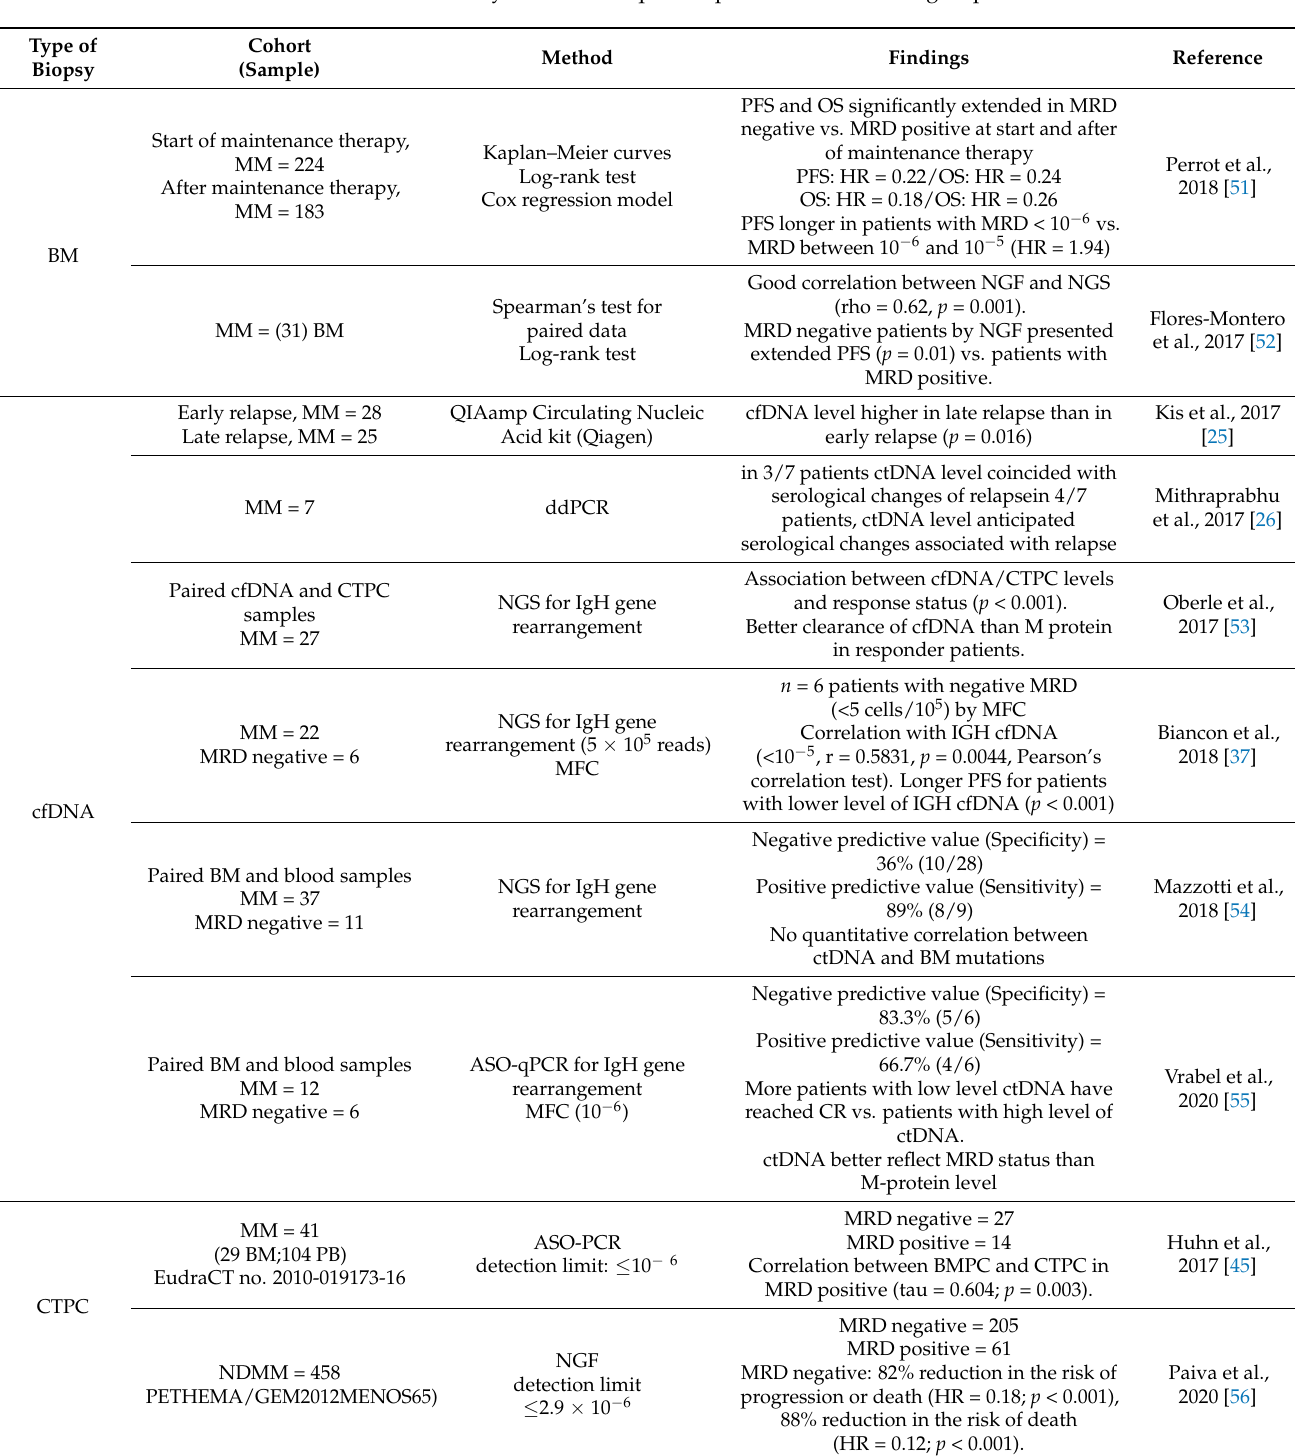
Table 3. Summary of BM and liquid biopsies evidence as drug response and MRD